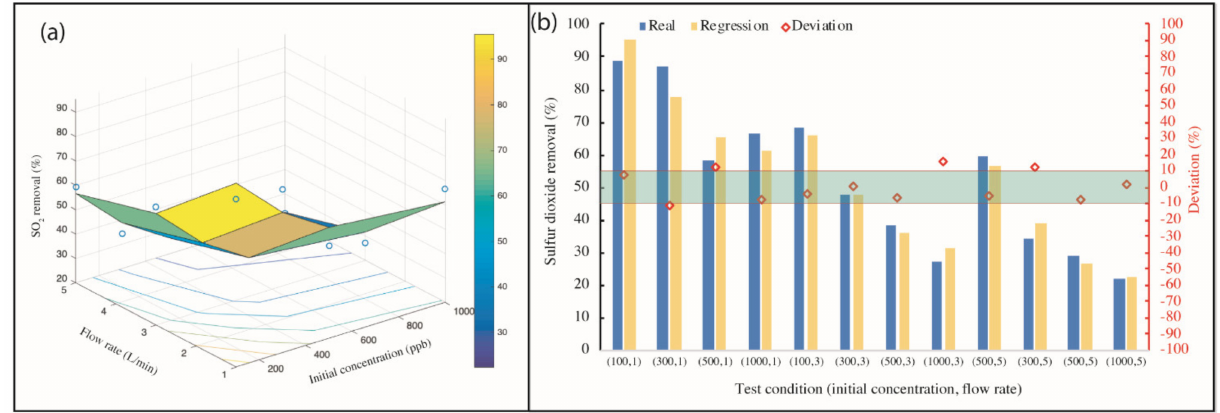
Figure 11. Validation of the regression model: ( a ) Real data (the blue circles) against the modeled respond surface; ( b ) quantitative test with deviations (deviation: [the difference between predicted data and real data] against the real data in